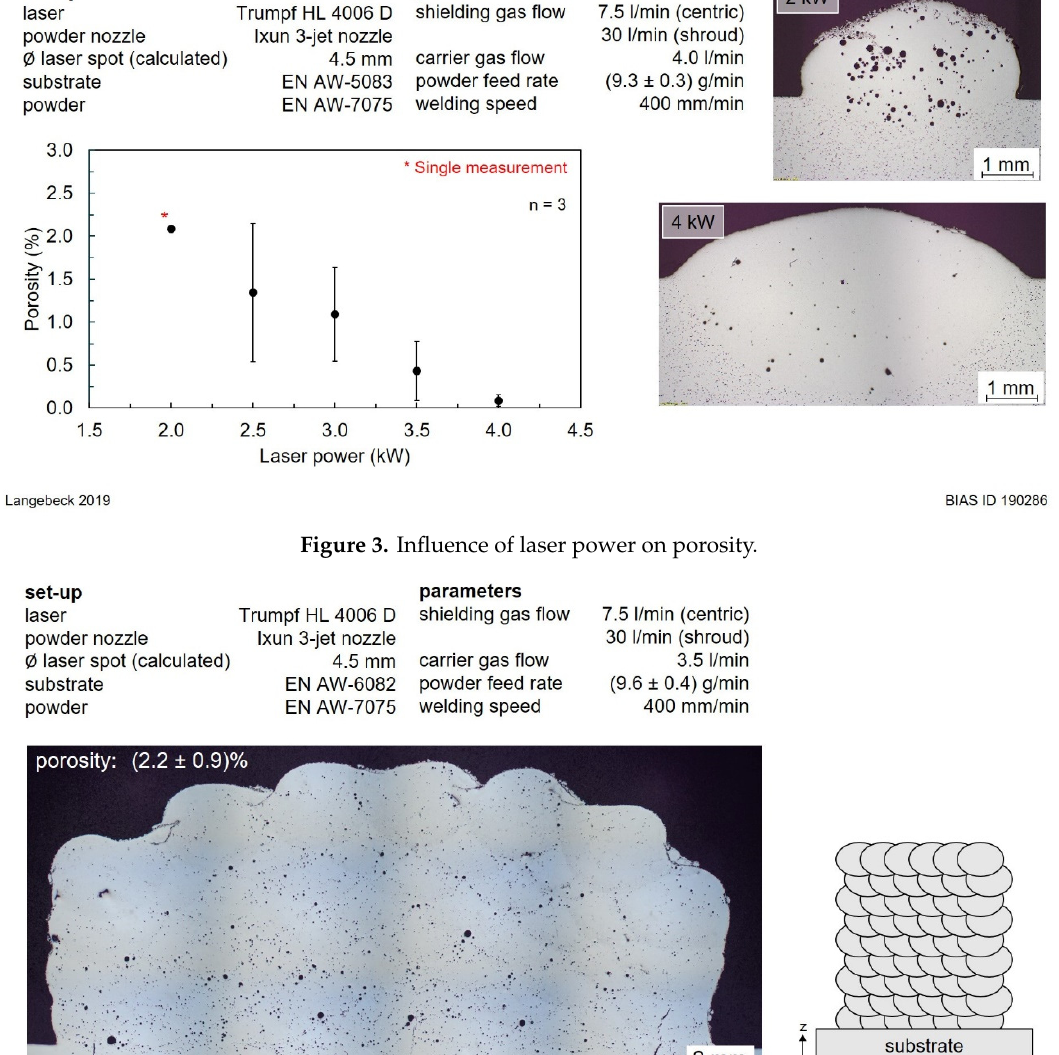
Figure 4. Schematic view of built-up strategy; cross section of large part for hardness measurements as well as tensile tests.